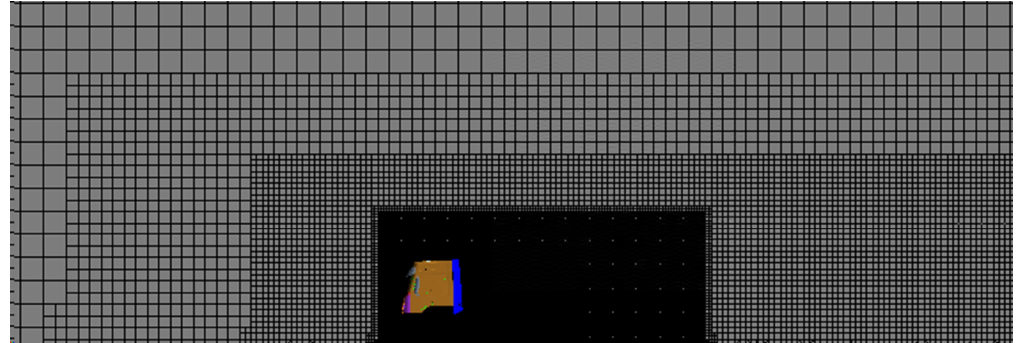
Figure 3. Partial mesh schematic diagram of the middle section.